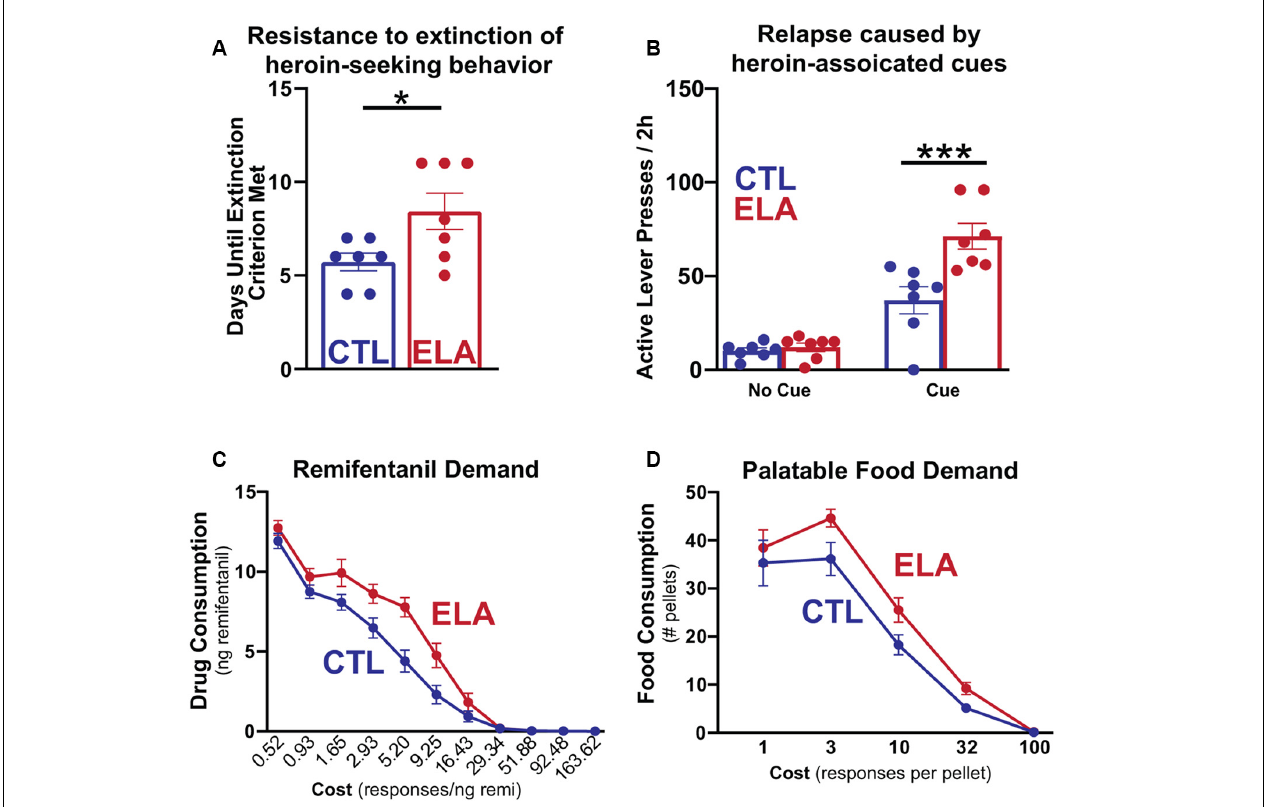
FIGURE 1 | Early life adversity (ELA) augments opioid-seeking behaviors and increases the demand for opioid drugs and highly palatable food. Adapted from Figures 1, 2 in Levis et al. (2019). (A) Female LBN-experienced (ELA) rats trained to self-administer intravenous heroin engage in more persistent heroin-seeking behavior after the withdrawal of the drug and (B) augmented relapse induced by heroin-associated cues than their control (CTL) counterparts. (C,D) On an economic task measuring sensitivity to increasing cost to obtain the desired reward, ELA rats are willing to exert more effort to access both opioid drug and food rewards at a higher cost than controls. This indicates increased demand for opioids and highly palatable food that is relatively insensitive to high costs. * p < 0.05; *** p <